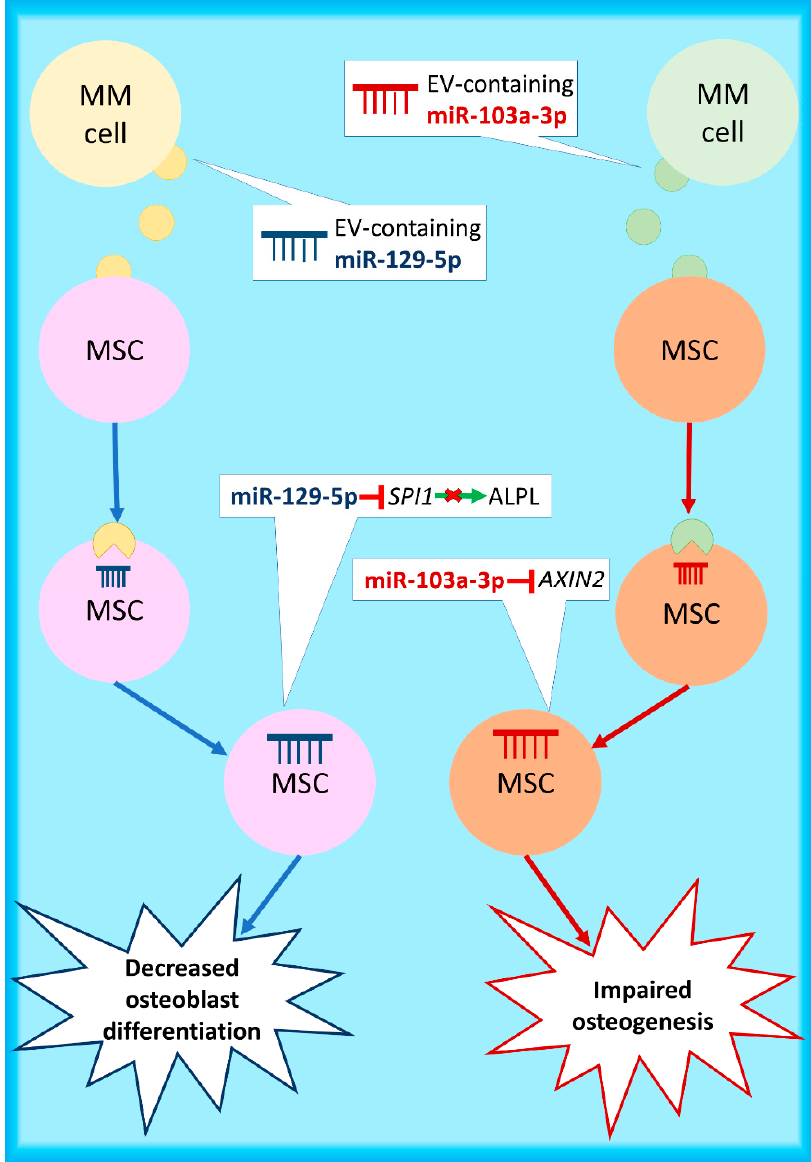
Figure 3. MM-derived extracellular vesicles (EVs) containing miRNAs can be internalized from MSCs, leading to diminished osteogenic